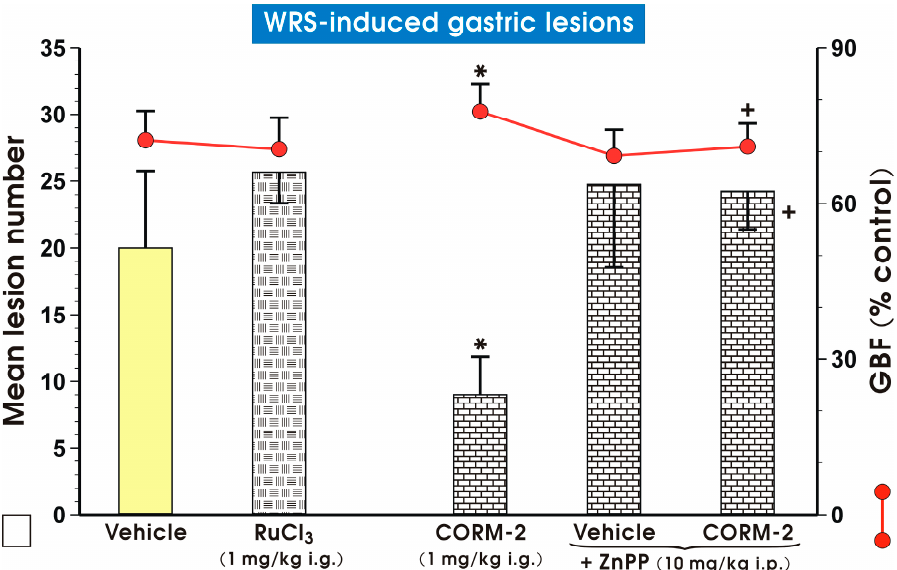
Figure 2. Mean lesion number and gastric blood flow (GBF) in gastric mucosa pretreated with vehicle (saline; i.g.; yellow pattern), RuCl 3 (1 mg/kg i.g.; mosaic patttern), carbon monoxide releasing molecule 2 (CORM-2, 1 mg/kg i.g.; brick pattern) and zinc protoporphyrin IX (ZnPP, 10 mg/kg, intraperitoneally (i.p.); brick pattern) administered alone or in combination with CORM-2 and compromised 30 min later by water immersion and restraint stress (WRS). Results are mean ± S.D. of 6–8 animals for each experimental group. Asterisk indicates significant change ( p < 0.05) as compared with vehicle (saline). Cross indicates significant change ( p < 0.05) as compared with the group treated with CORM-2 (1 mg/kg i.g.) alone.